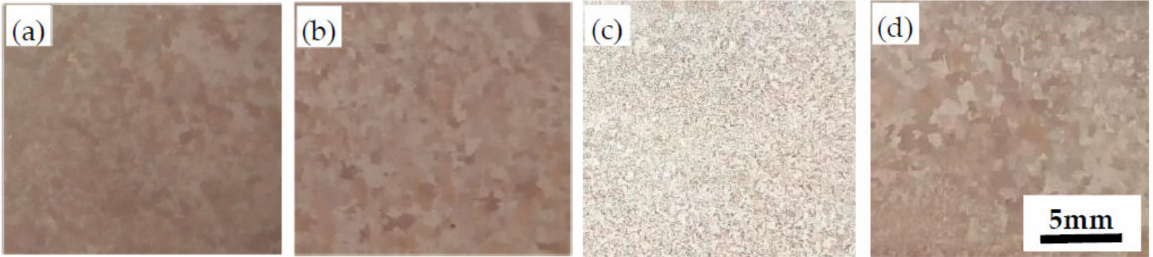
Figure 4. Macrostructure of the ZCuPb20Sn5Ni3-0.1P-yB alloy. ( a ) B = 0.0 wt.%; ( b ) B = 0.05 wt.%; ( c ) B = 0.1 wt.%; ( d ) B = 0.2